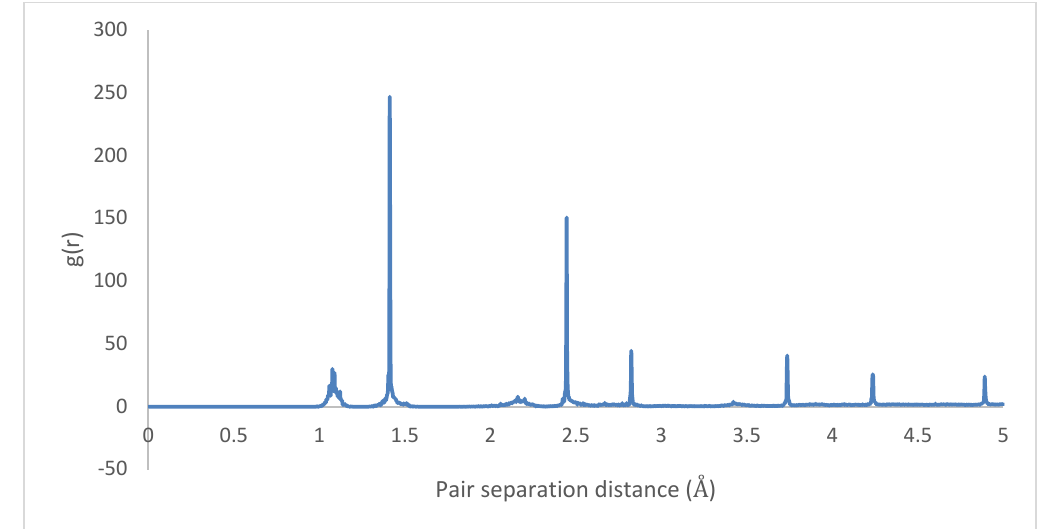
Figure 25. Radial distribution function: 4PPV–7 nm × 7 nm graphene (final).